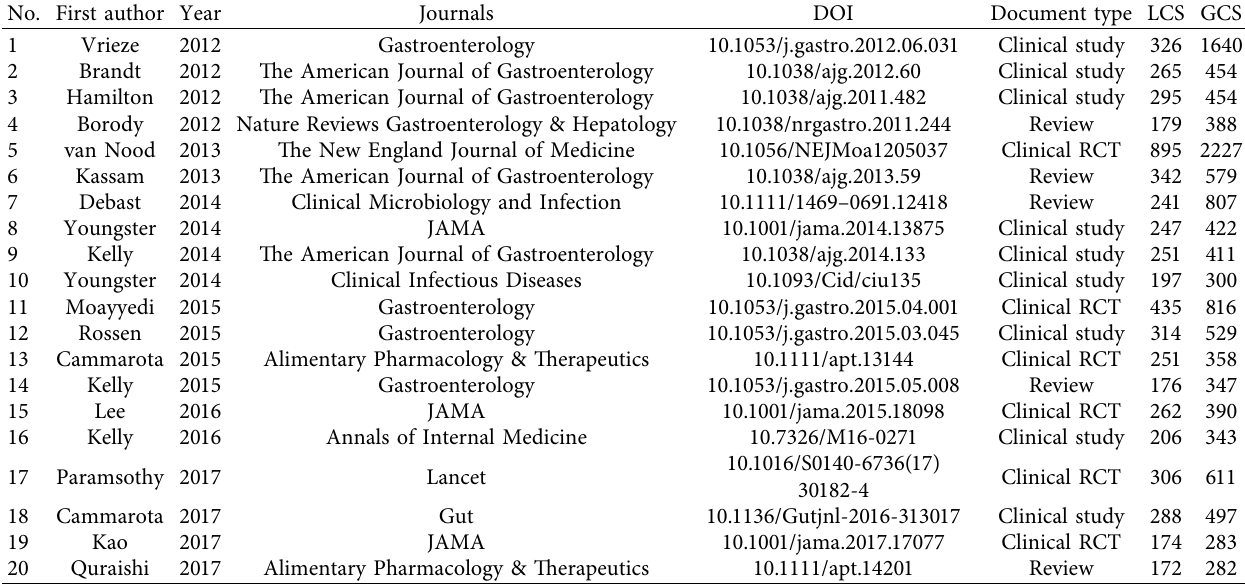
Table 5: Te FMT-related classic papers in historical citation